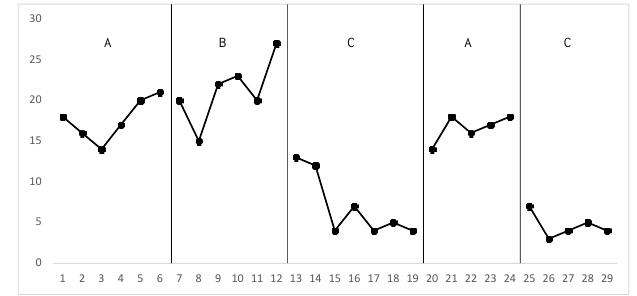
Figure 2. Visual Display of Class Data Collected Using an ABCAC Design: Instances of Disruptive